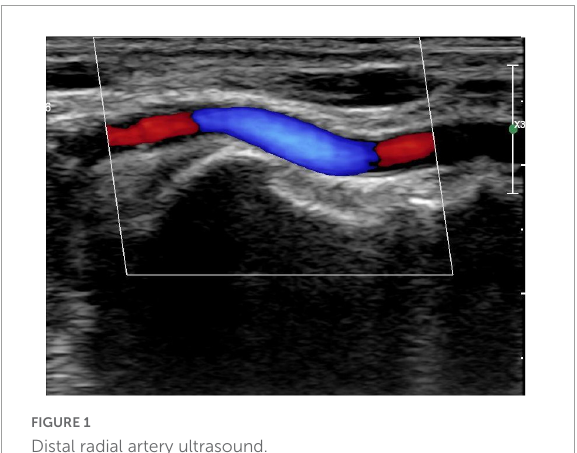
FIGURE1 Distal radial artery